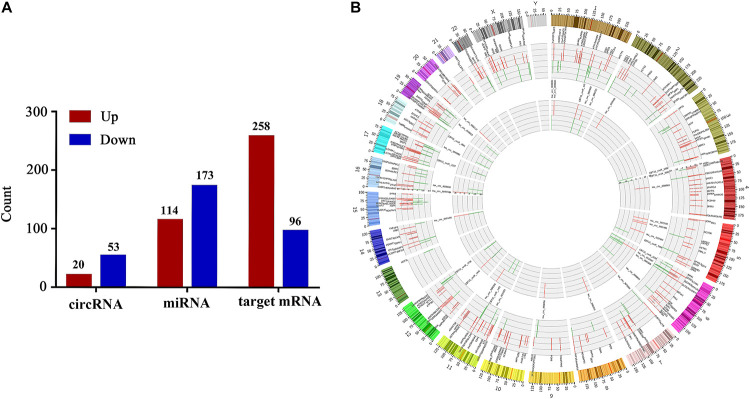
Differentially expressed circRNAs, miRNAs and target mRNAs between LD group and normal control group. Part (A) shows the number of DE-circRNAs, DE-miRNAs and target DE-mRNAs. Part (B) demonstrates the distribution of DE-circRNAs and target DE-mRNAs in the genomic level, and the up-regulated expression is shown in red, the down-regulated expression is shown in green. The height represents the degree of differential expression. DE, differentially expressed; circRNA, circular RNA; miRNA, microRNA.